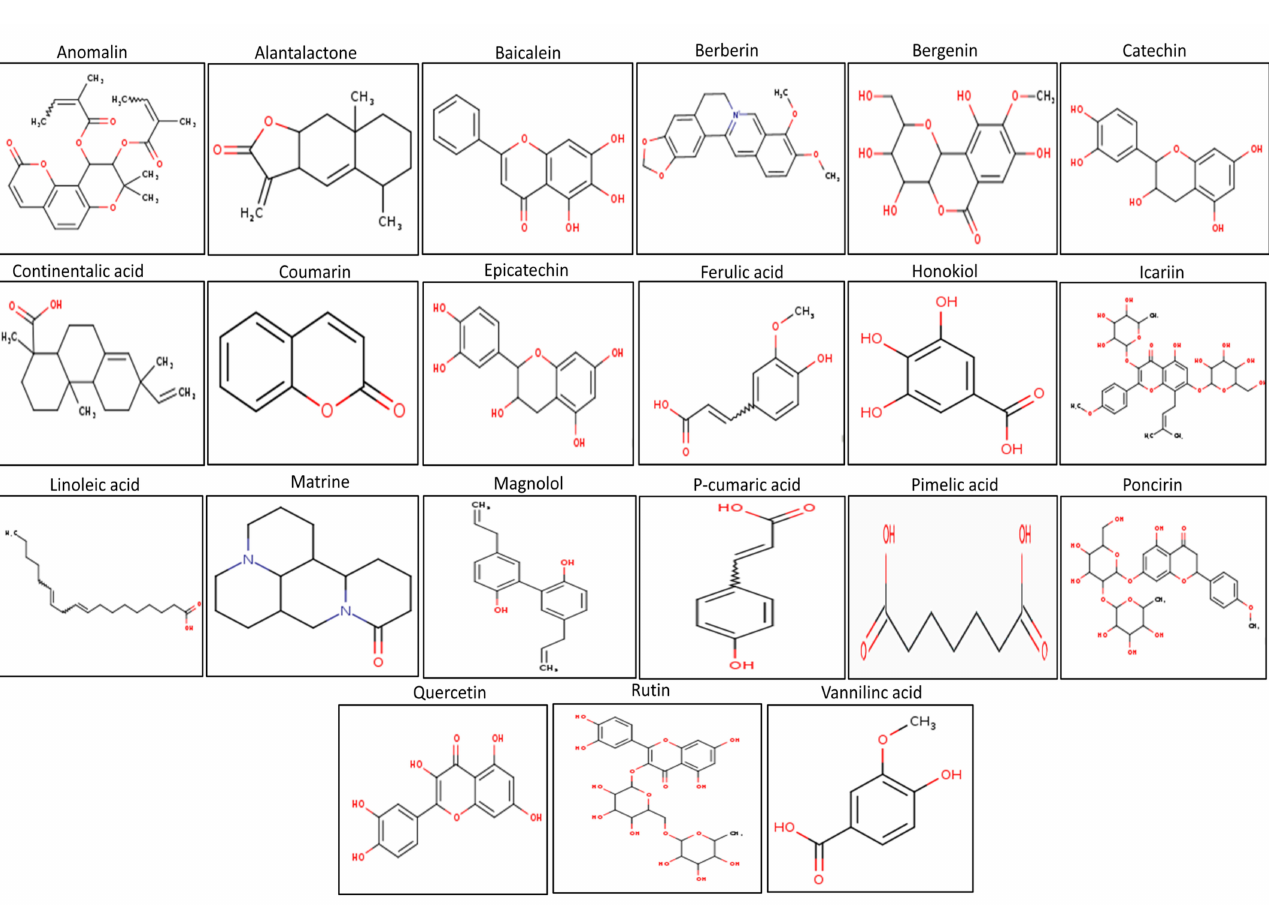
Figure 1. The selected plant product docked against the TLR-4, NF- κ B, JNK, and